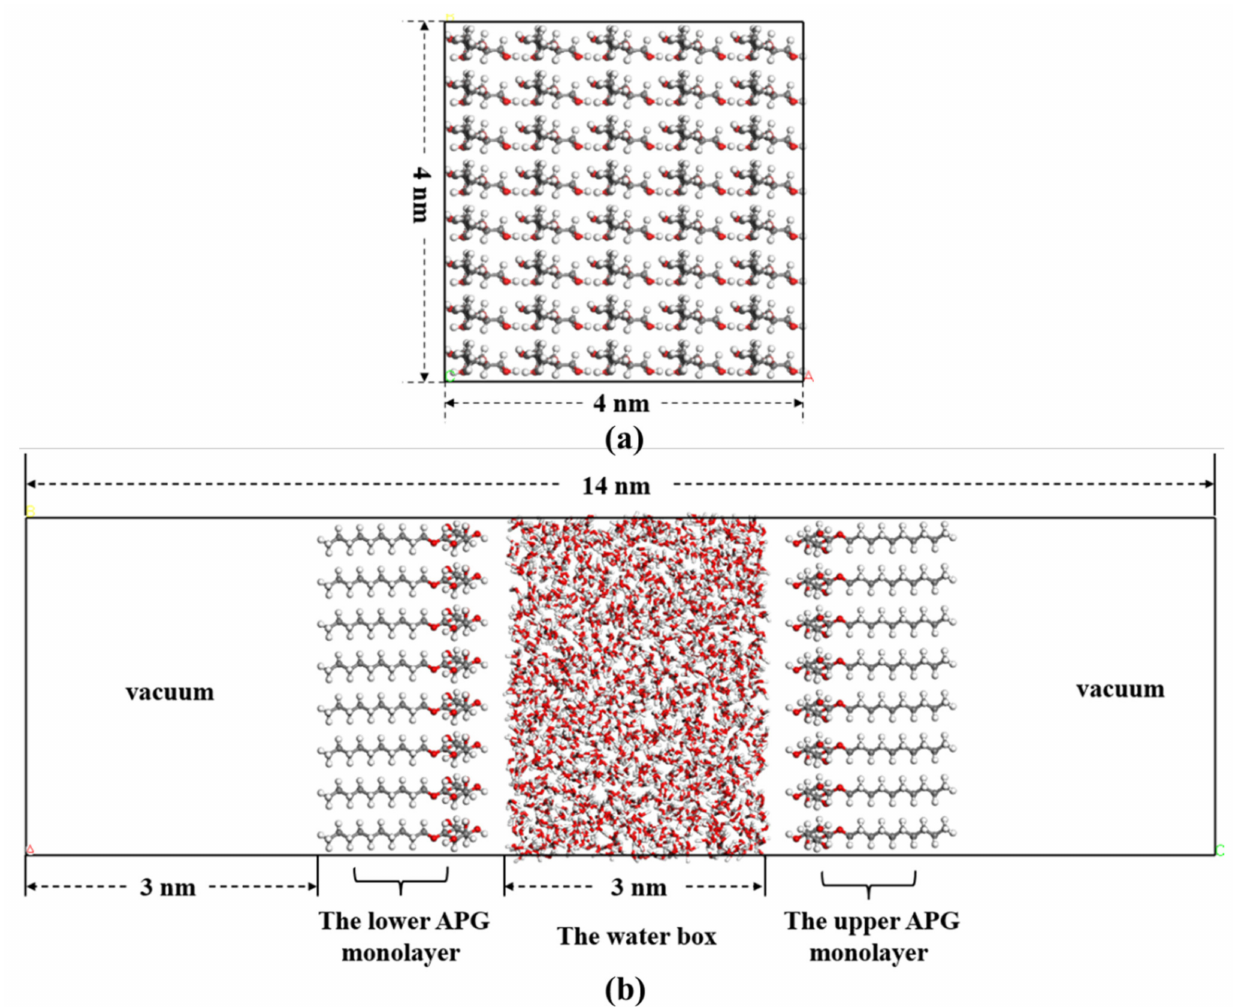
Figure 1. Foam model. ( a ) Side view of model, ( b ) Front view of